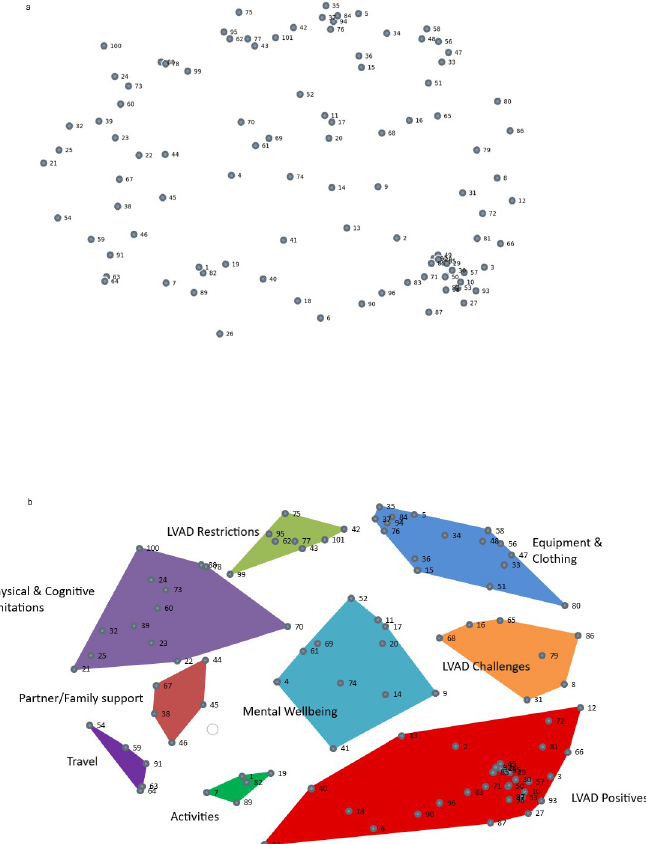
Fig 1. Points map with overlay of nine cluster solution. a. Points maps are visual representations of the two- dimensional solution generated from the similarity matrix created from participants choices in stage 2. Frequently grouped statements are located proximally while less frequently grouped statements are distal to each other. b. Cluster maps are visual representations of the hierarchical cluster analysis solution, and represent similarities and inter- relationships between the domains and items. Large clusters represent broader concepts, whereas smaller clusters represent more narrowly focused homogenous domains.